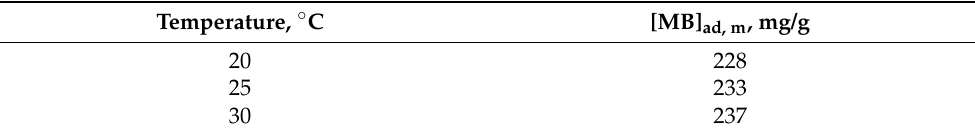
Table 3. Effect of temperature on the theoretical maximum adsorption